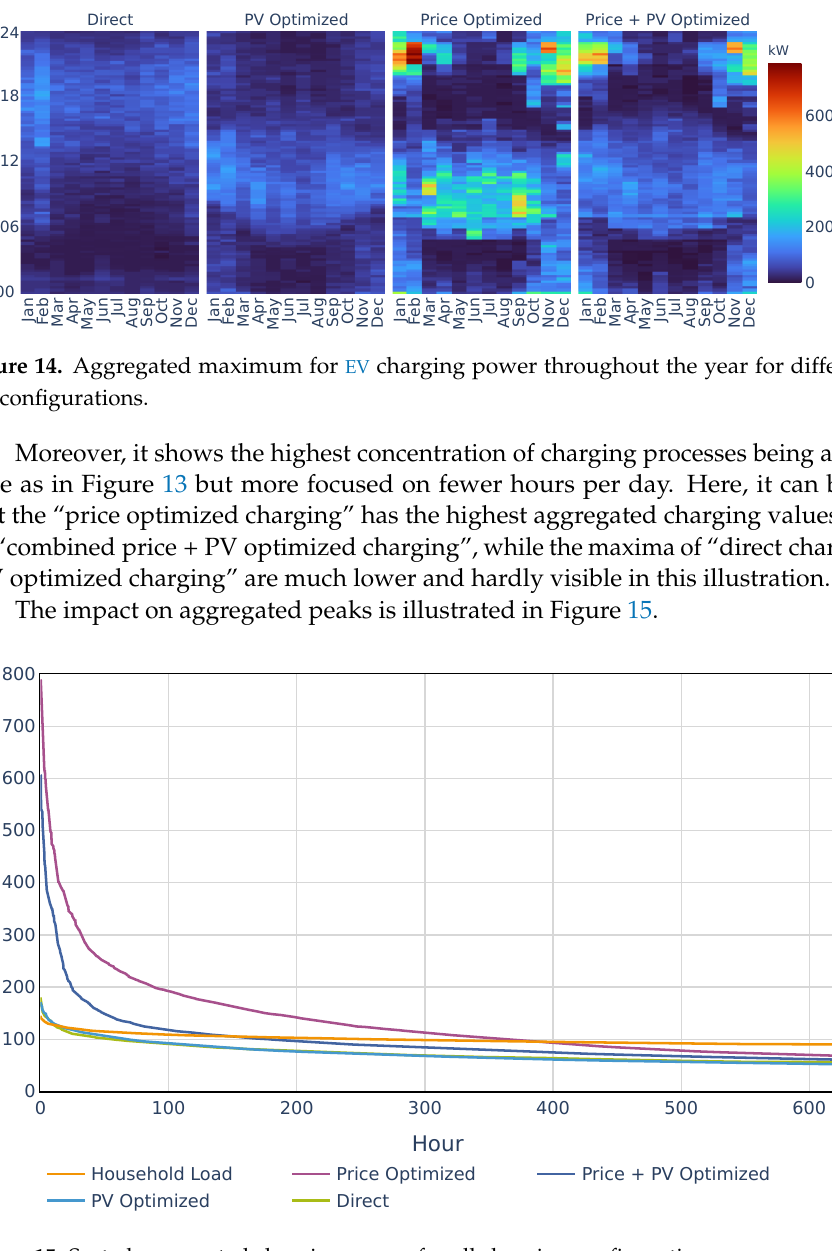
Figure 15. Sorted aggregated charging power for all charging